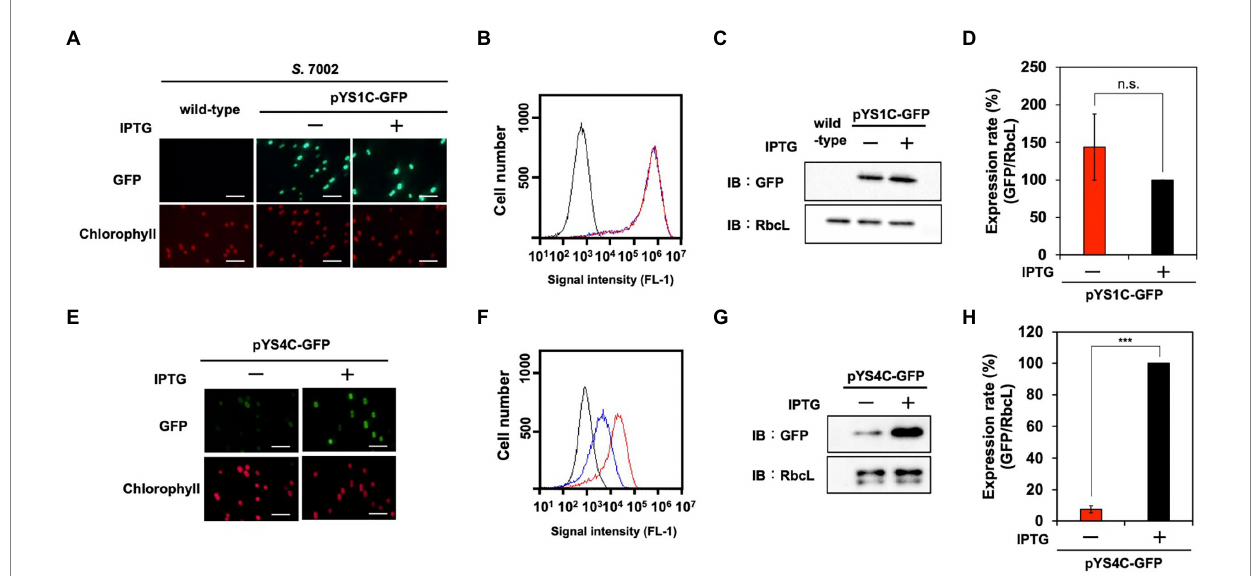
FIGURE 5 Utilization of expression plasmid pYS1 and pYS4 in S . 7002. The GFP expression levels in pYS1C-GFP (A–D) and pYS4C-GFP transformants (E–H) were analyzed with (+) and without ( − ) 1 mM IPTG. (A,E) Fluorescence microscopy images. The GFP and chlorophyll images are shown. White bar: 10 μ m (B,F) FACS analysis of GFP fluorescence. Signal intensity of FL-1 indicating GFP fluorescence in S . 7002 wild-type (black), pYS- or pYS4-GFP in the presence (red) and absence (blue) of IPTG are shown. (C,G) Western blotting analysis. The protein extracts obtained from S . 7002 cells were subjected to SDS-PAGE and analyzed by western blotting using antibodies against GFP. RbcL was used as an internal control. (D,H) Comparison of GFP signals. The signal intensity of GFP obtained from western blot analysis was normalized to that of RbcL, and the ratio of GFP signal in the presence of IPTG was set to 100. Bars represent the mean ± SEM ( n = 3; *** p <